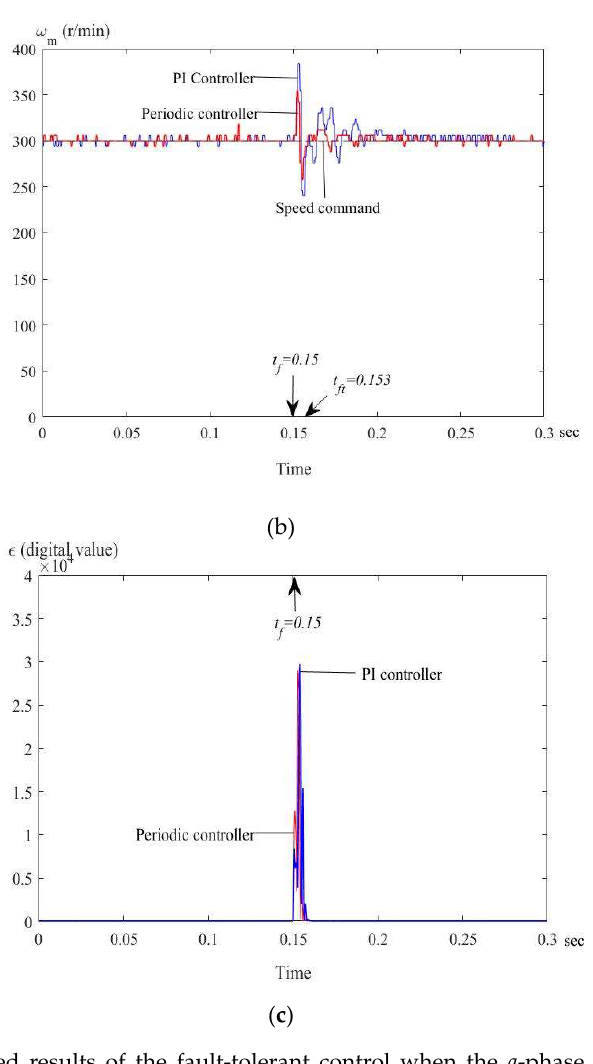
Figure 20. Measured results of the fault-tolerant control when the a -phase was short-circuited: ( a ) currents of the PI controller; ( b ) speed responses; ( c ) performance indexes.